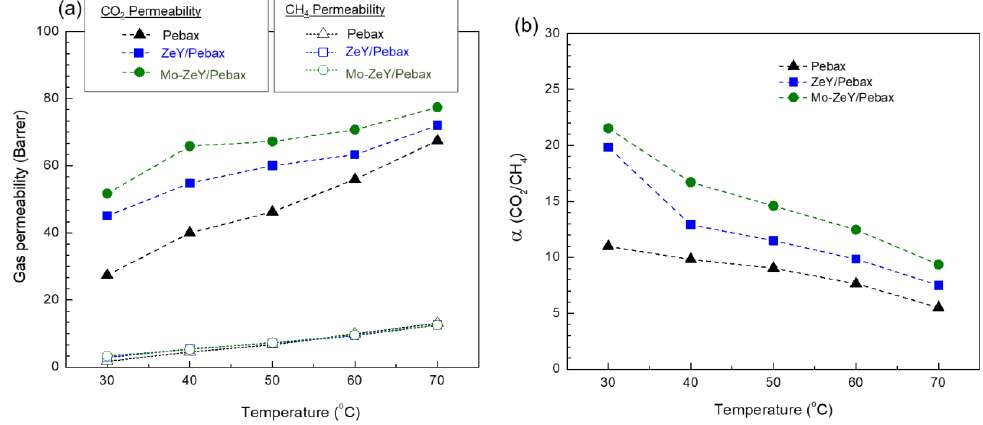
Figure 10. ( a ) Gas permeability and ( b ) CO 2 /CH 4 separation factor of neat Pebax and MMMs Figure 10. (a) Gas permeability and (b) CO 2 /CH 4 separation factor of neat Pebax and MMMs with 5 wt.% of ZeY, and Mo-ZeY tested at 1 bar of transmembrane pressure and 30 to 70 °C.